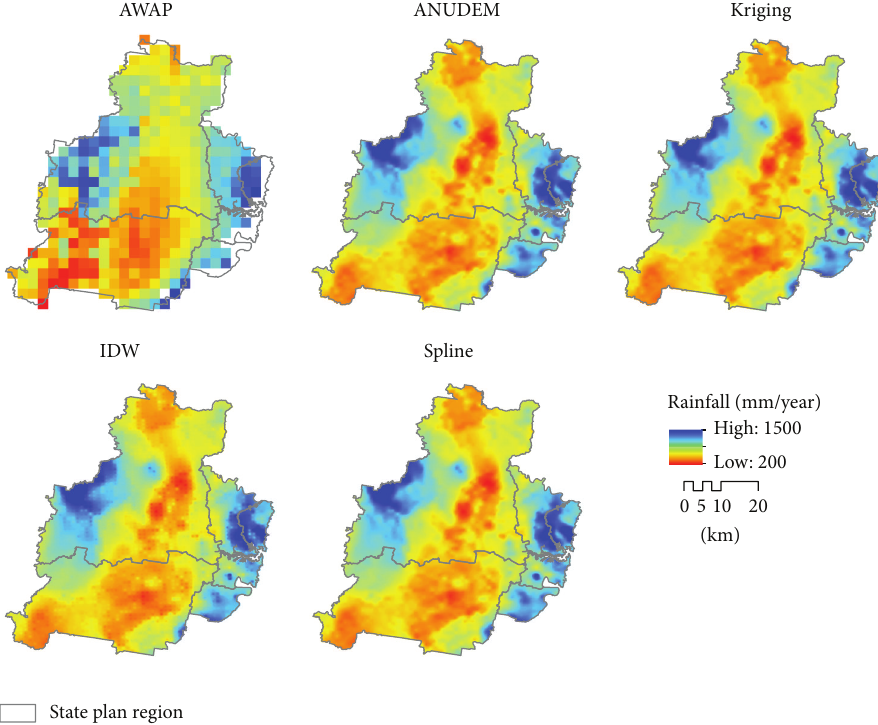
Figure 4: Comparison of interpolation methods for annual mean rainfall against